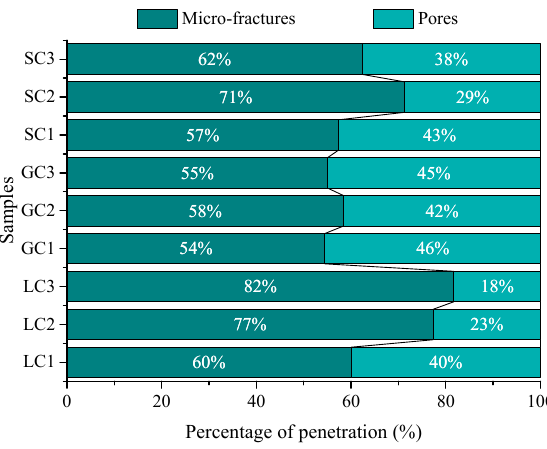
Figure 16. Percentage of permeability of different pore media.